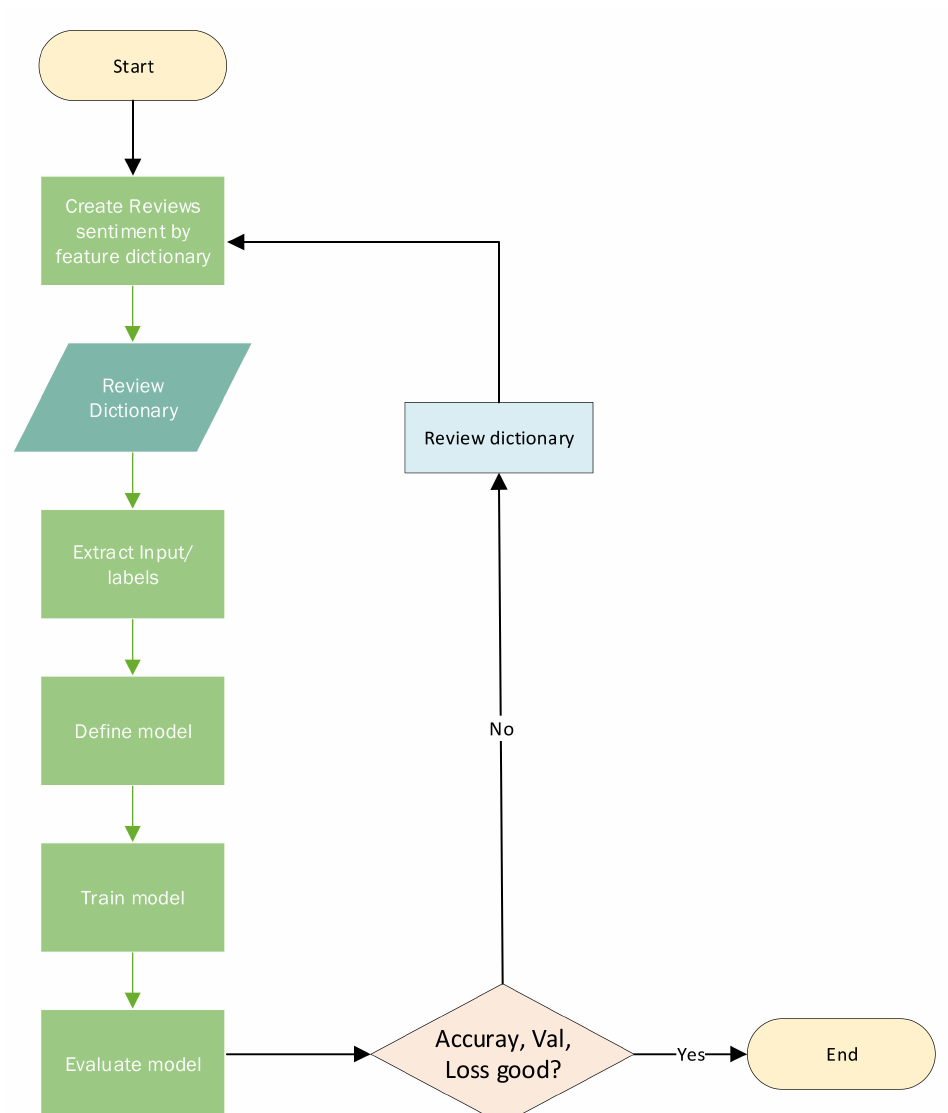
Figure 7. Workflow of building the machine learning